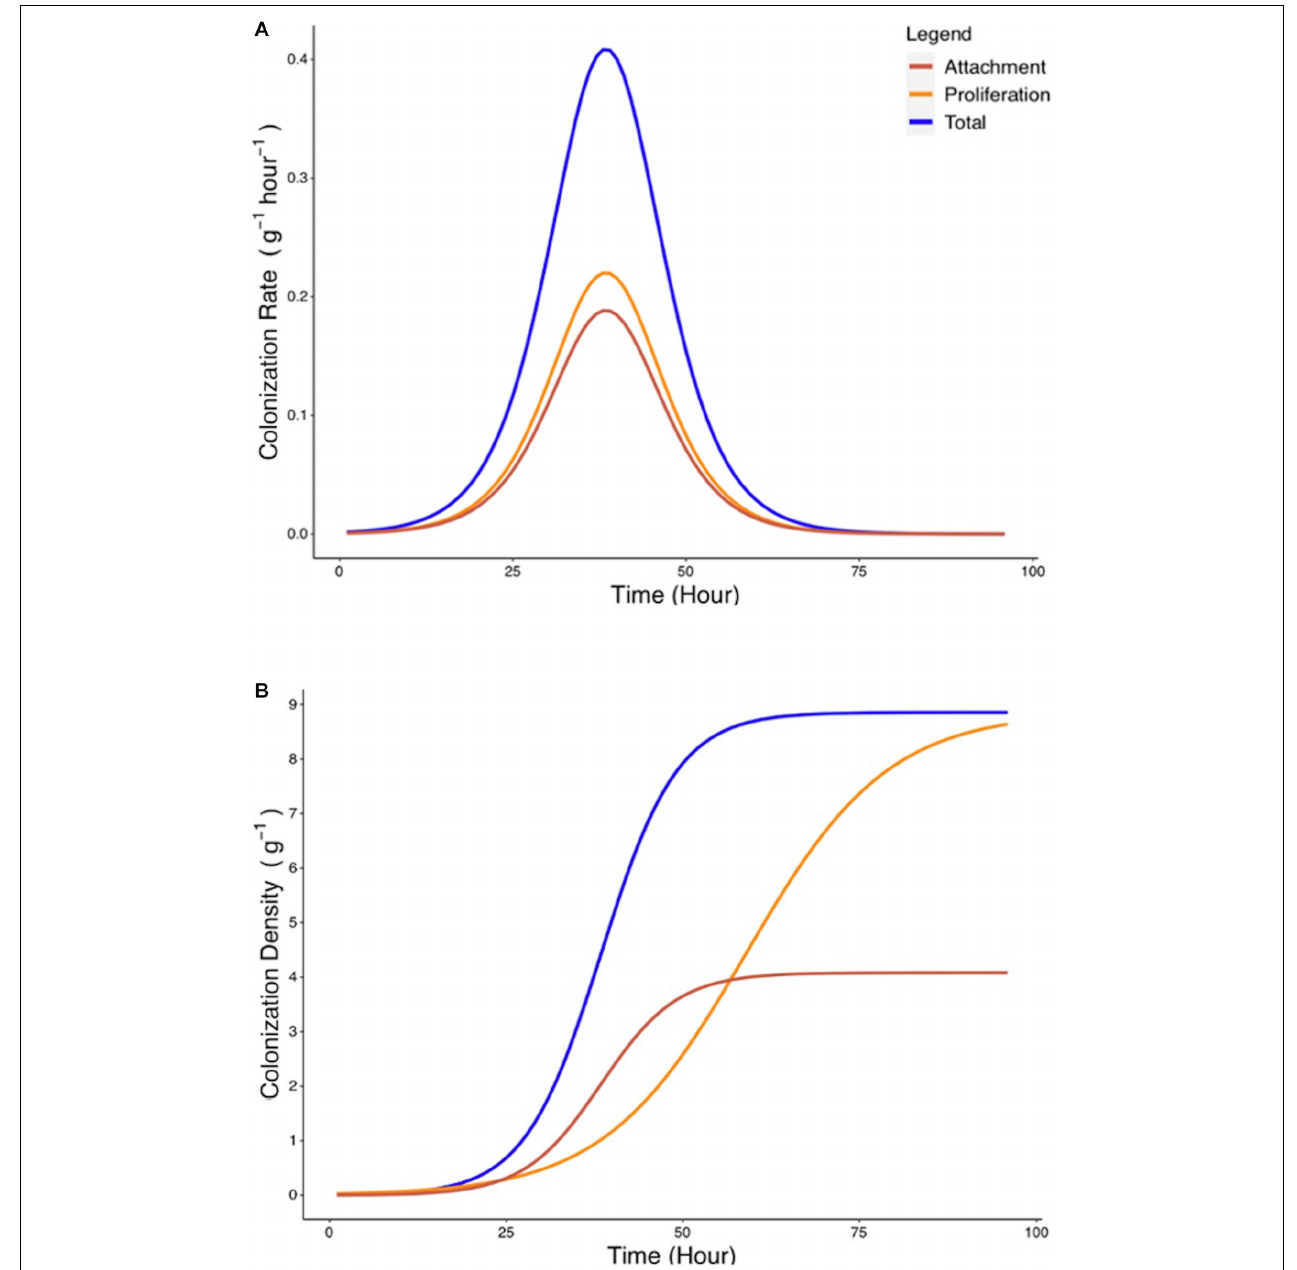
FIGURE 6 | Estimated rate of bacterial attachment to the rhizoplane. (A) The rates of total colonization (R c , blue) and proliferation (R p , yellow) were calculated based on Eqs. 6, 7. The rate of attachment (R a , red) was calculated based on Eq. 8. (B) Colonization density due to attachment was estimated by integration of Eq.